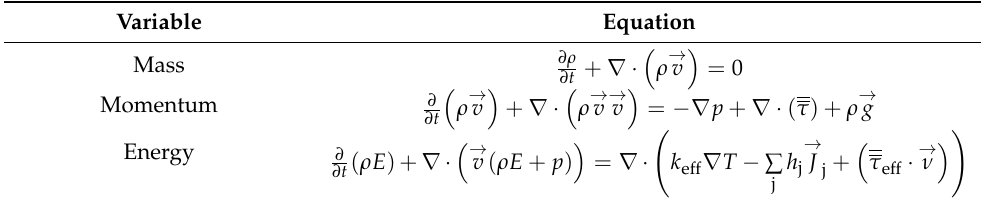
Table 1. Governing equations of the thermal plasma model.